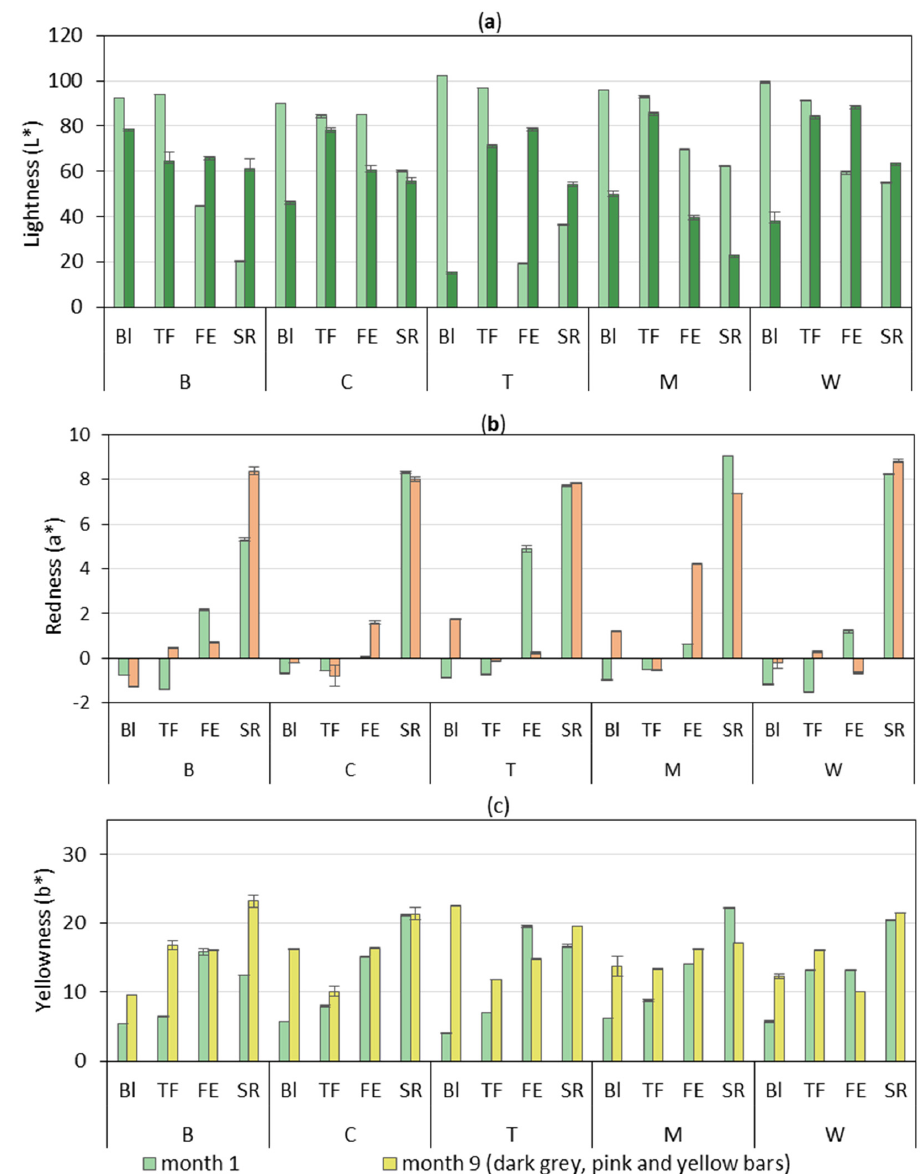
Figure 6. CIELab values, ( a ) lightness (L*); ( b ) redness (a*); and ( c ) yellowness (b*) of the suncream